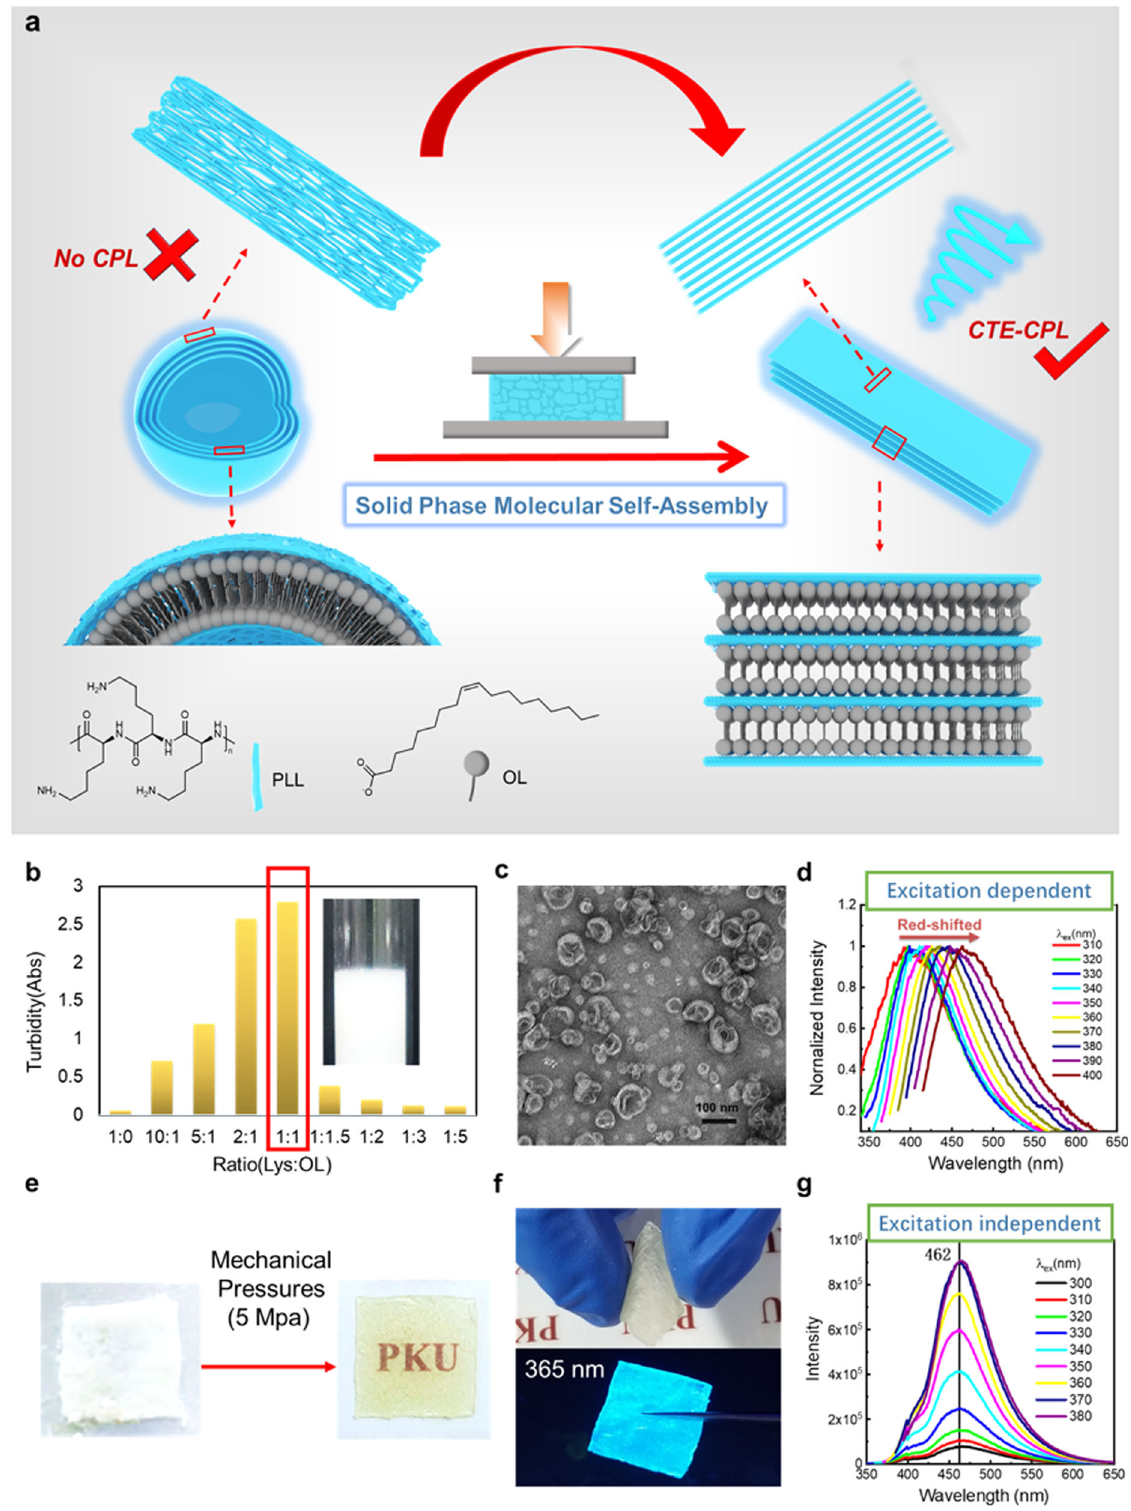
Fig. 1 Solid phase molecular self-assembly (SPMSA) of α -poly- L -lysine-sodium oleate (PLL-OL). a The schematic illustration of the solid phase molecular self-assembly (SPMSA) of PLL-OL. b Turbidity of PLL-OL aqueous suspension at different lysine: oleate (Lys: OL) ratio ([Lys] = 10 mM). c TEM (transmittance electron microscopy) image for the structures formed in the PLL-OL suspension (Lys:OL = 1:1, [OL] = [Lys] = 10 mM). d Emission spectra of PLL-OL aqueous suspension at different excitation wavelengths (Lys:OL = 1:1, [OL] = [Lys] = 50 mM). e The fi lm is obtained by pressing the precipitate. f The photo of the fi lm under daylight (upper) and 365 nm UV light (lower), respectively. g Emission spectra of PLL-OL fi lm at different excitation